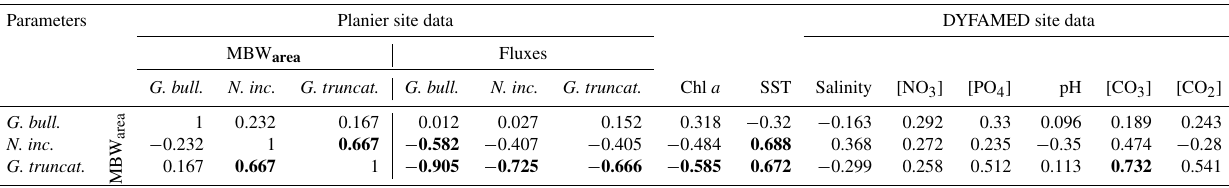
Table 5. Correlation matrix of seasonal (monthly) test weights and the environmental parameters from Planier (sediment trap and satellite data) and DYFAMED site (see Sect. 3.4). Significant correlations ( p < 0.05) are set in bold.